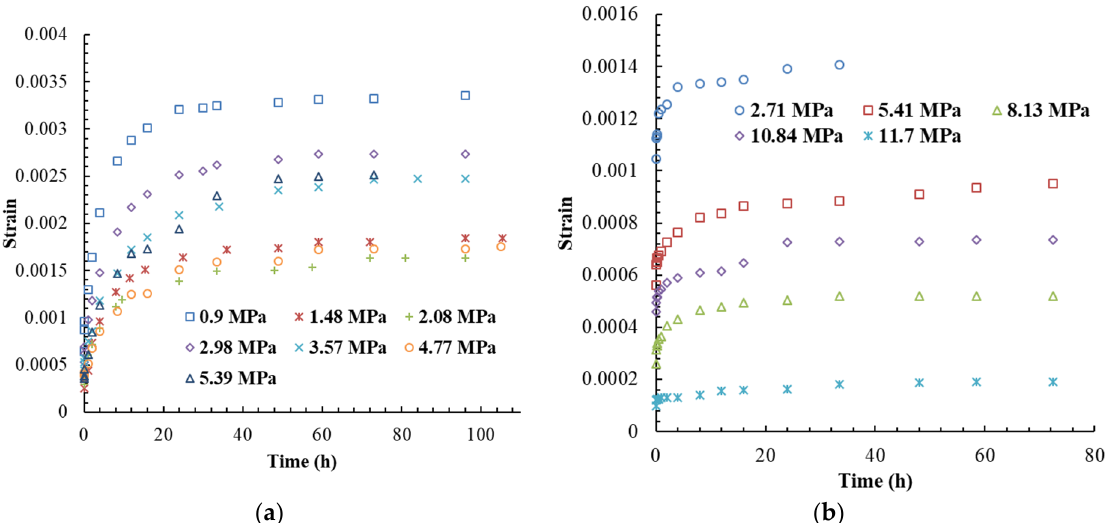
Figure 13. The curve of the uniaxial compression rheological test: ( a ) grey-green claystone, ( b ) mauve claystone.